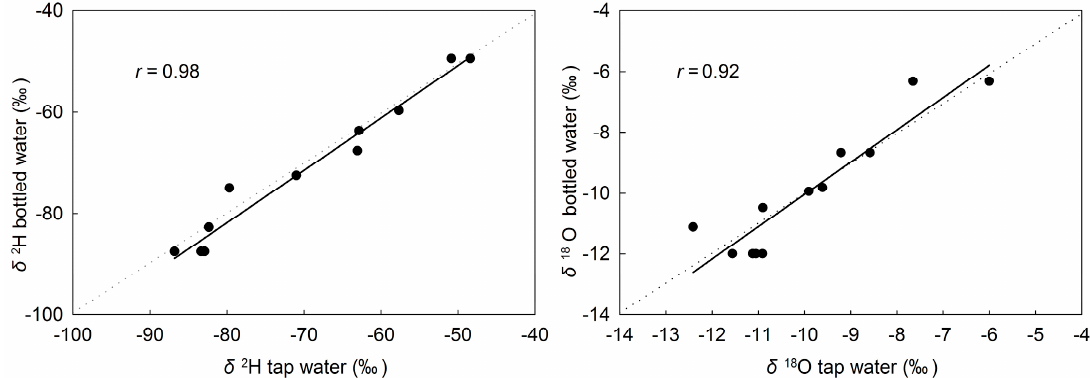
Figure 11. Hydrogen and oxygen isotope values of spring-sourced bottled water plotted against corresponding tap water isotope ratios. The dotted line is the line of equality (y = x) and the solid line is the linear least squares fitting.